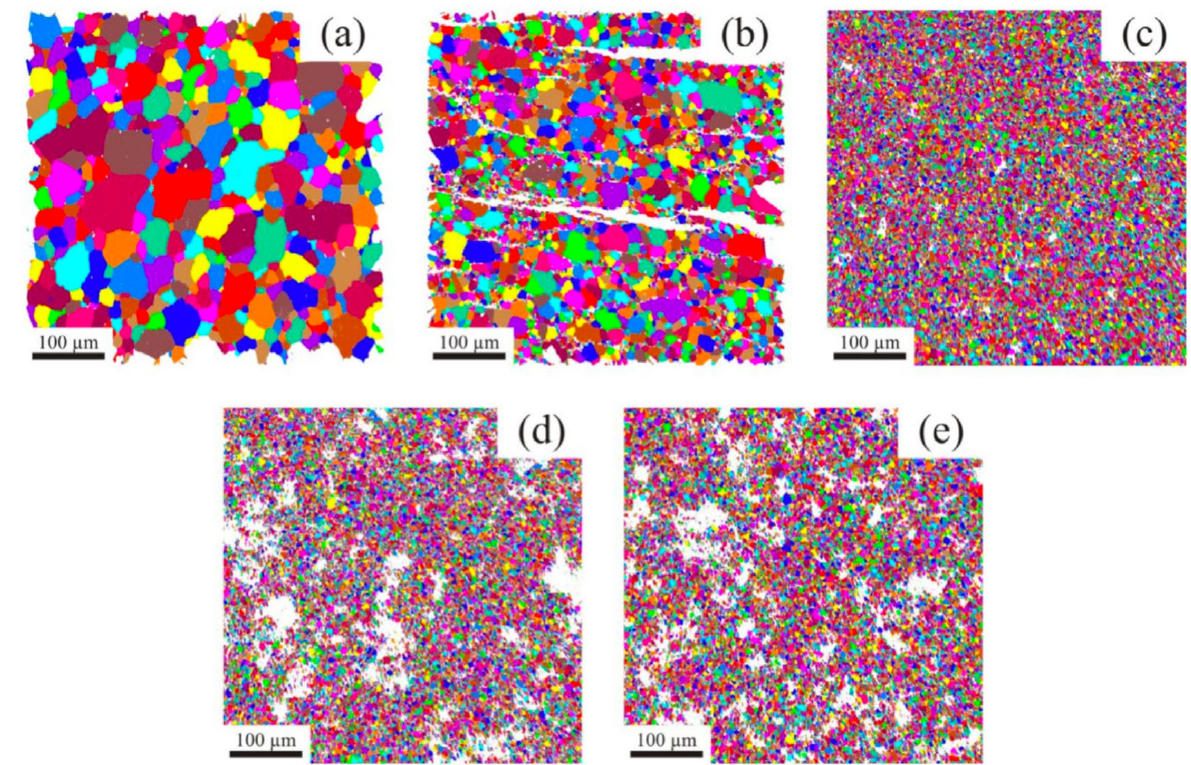
Figure 12. Grain size maps obtained by EBSD for the sintered samples: ( a ) Pure Ni, ( b ) MWCNT/Ni 6.5 vol.%, ( c ) MWCNT/Ni 12 vol.%, ( d ) MWCNT/Ni 18 vol.%, and ( e ) MWCNT/Ni 27 vol.%. Reproduced from [87] with per- mission from Elsevier,